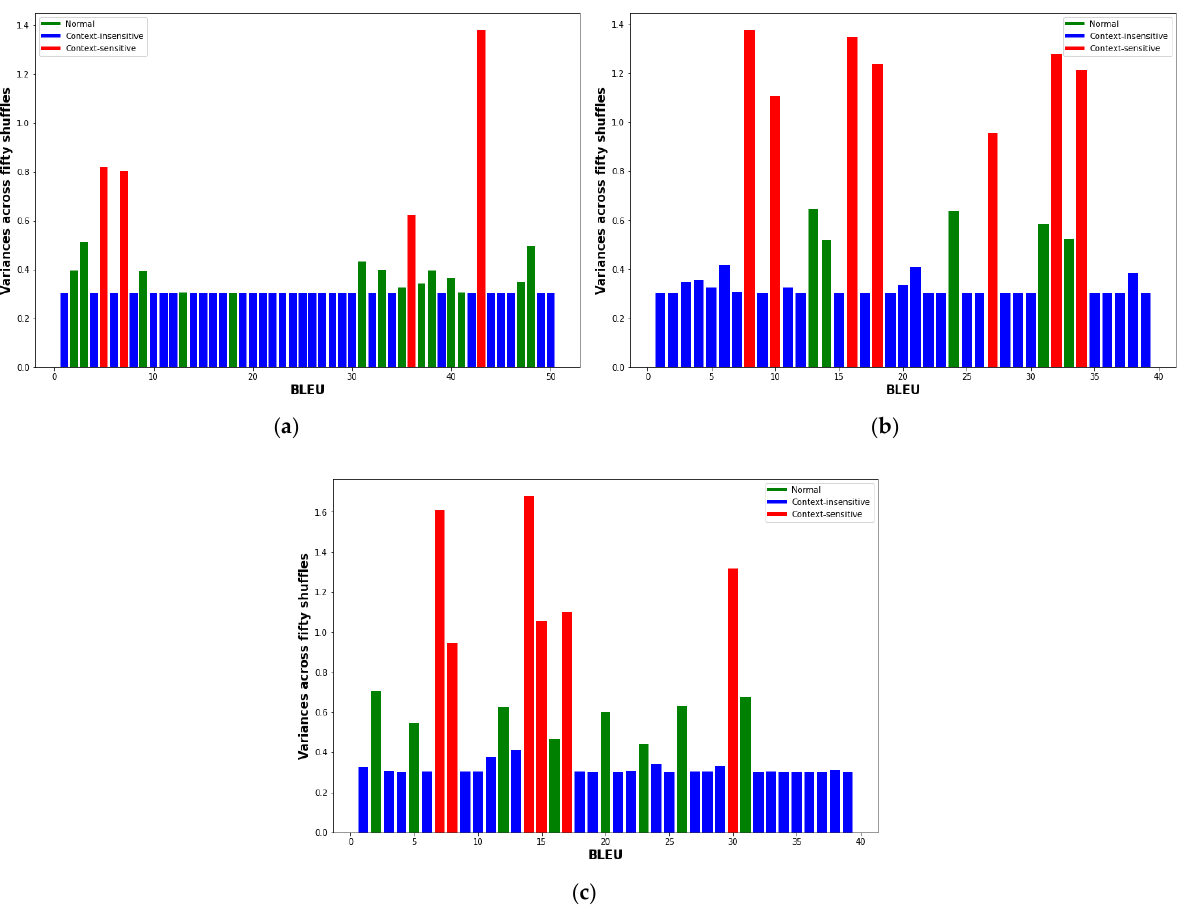
Figure 3. Mean variances of the test set sentences for BLEU and their corresponding classes (green: normal , blue: context‑insensitive and red: context‑sensitive ). ( a ) Hindi‑to‑English ( b ) Spanish‑to‑ English ( c )